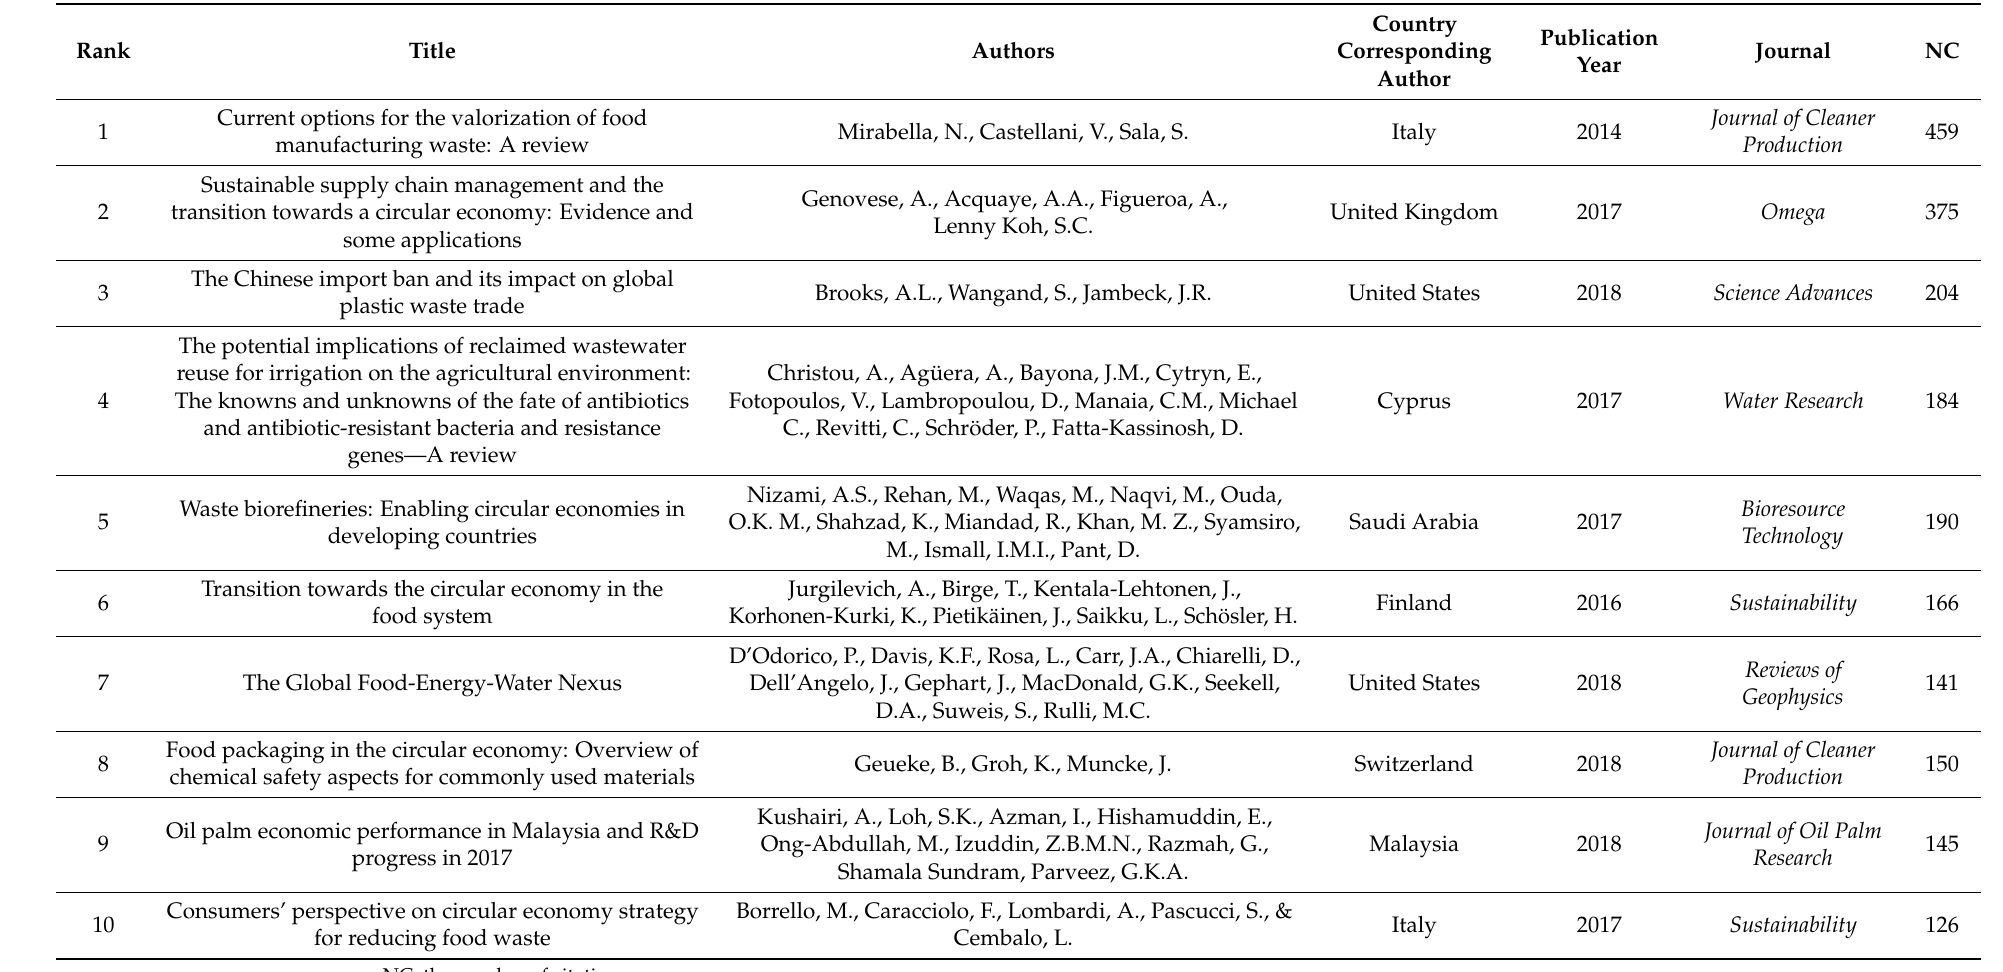
Table 5. Top 10 highly cited papers in citation frequency on circular economy and foods during